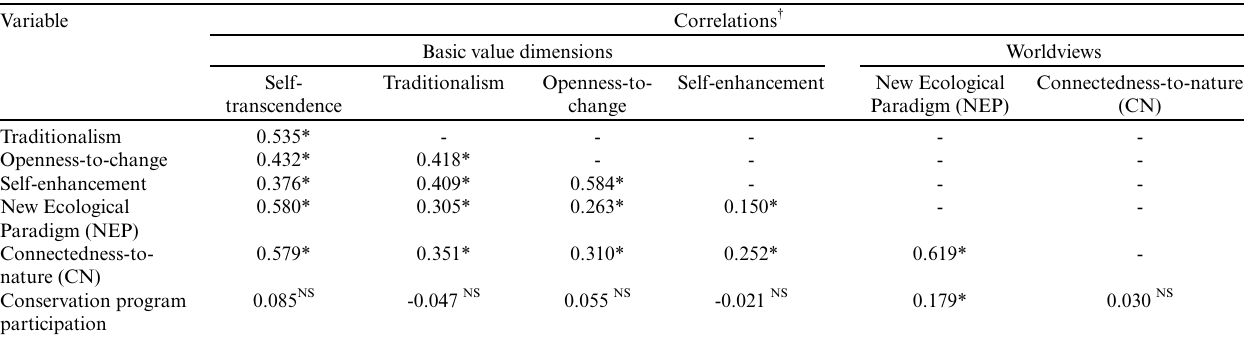
Table 2 . Correlations among four basic value dimensions, worldviews, and conservation program